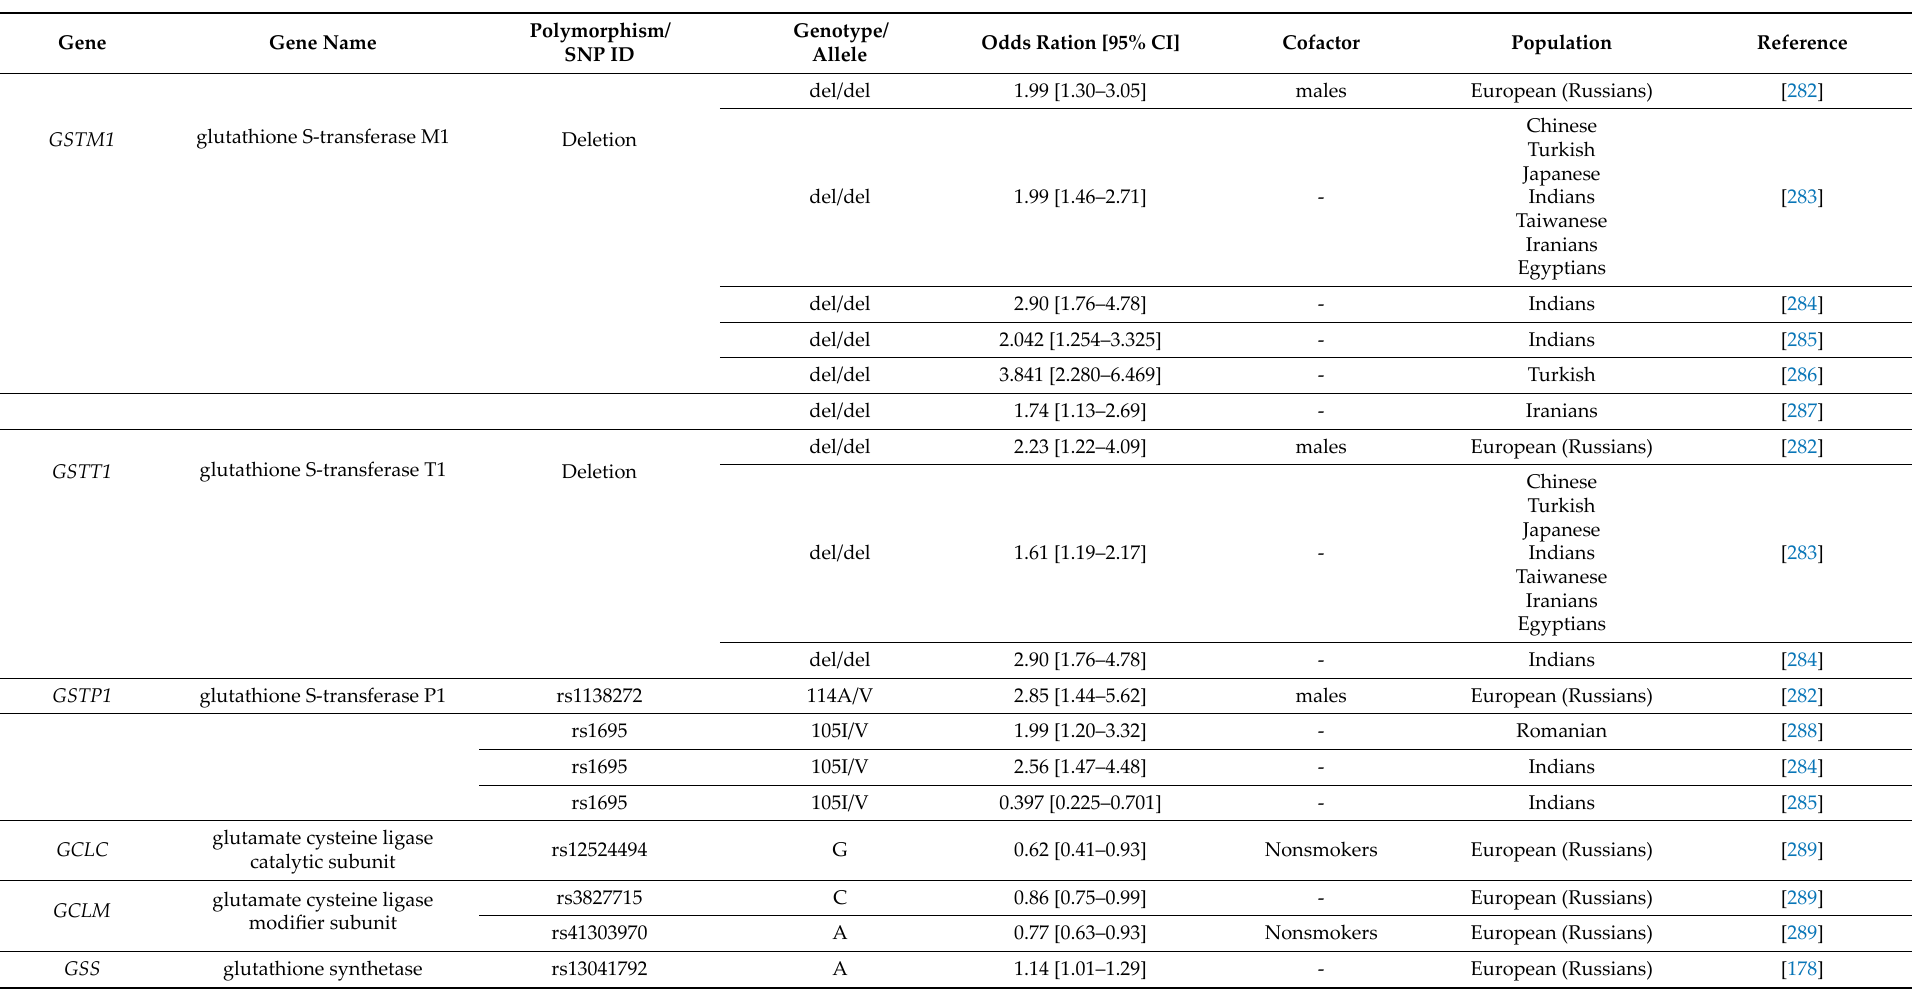
Table 1. Genetic association studies of enzymes involved in the regulation of redox homeostasis in type 2 diabetes